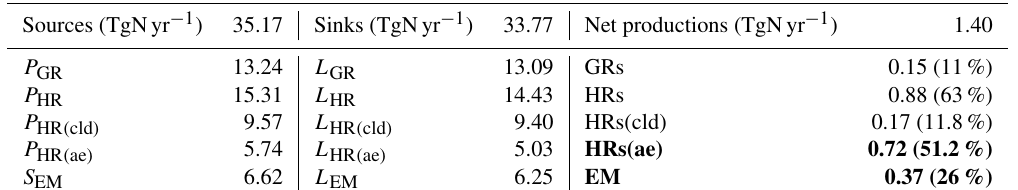
Table 8. Global sources and sinks of tropospheric HONO calculated by CHASER (2011). The bold figures signify the two pathways that contribute the most to tropospheric HONO.